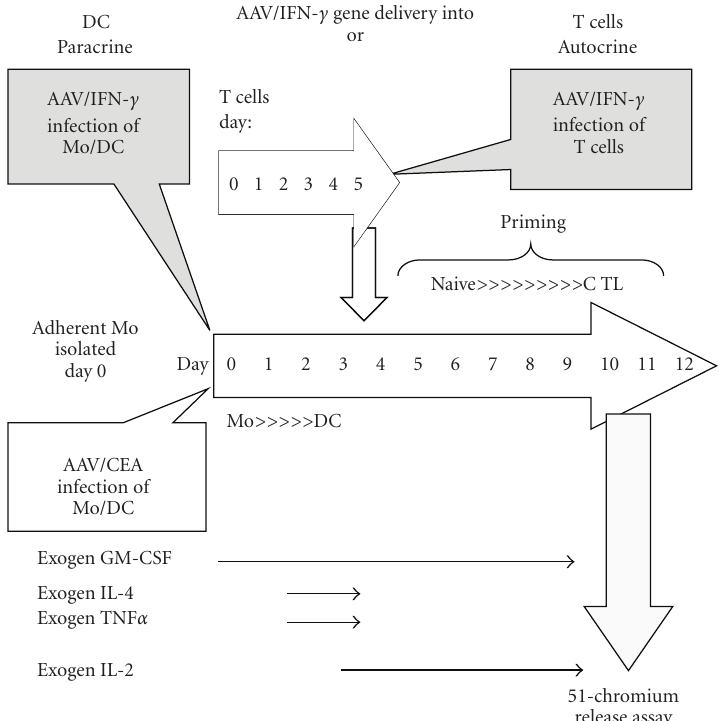
Figure 1: Structure of the cell treatment protocol. Shown is the temporal treatment of the Mo/DC and T cells and is self-descriptive. However, note that AAV/IFN- γ is used to infect Mo/DC at day zero, or naive T cells just prior to coincubation with AAV/antigen-loaded DC on day